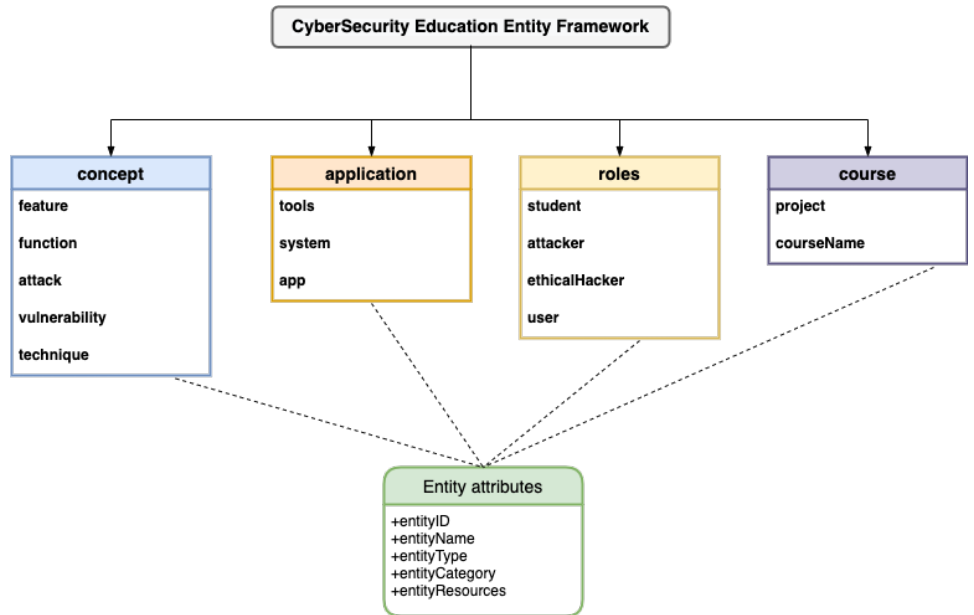
Figure 3. Cybersecurity Education Entity Framework as explained in Section 3.1.4. The figure shows the key entity types identified in the ontology. The green box with entity attributes shows the lists of the common attributes for each